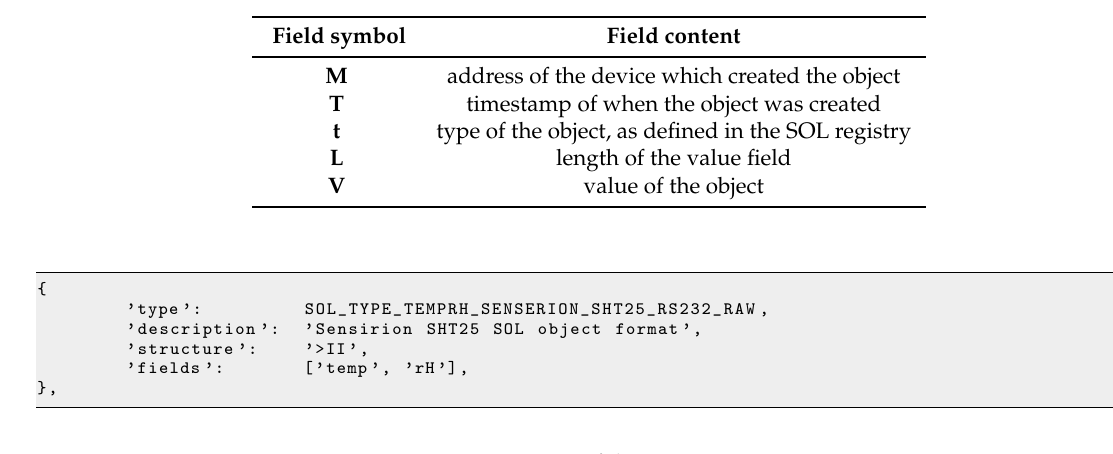
Figure 4. Excerpt of the SOL registry.